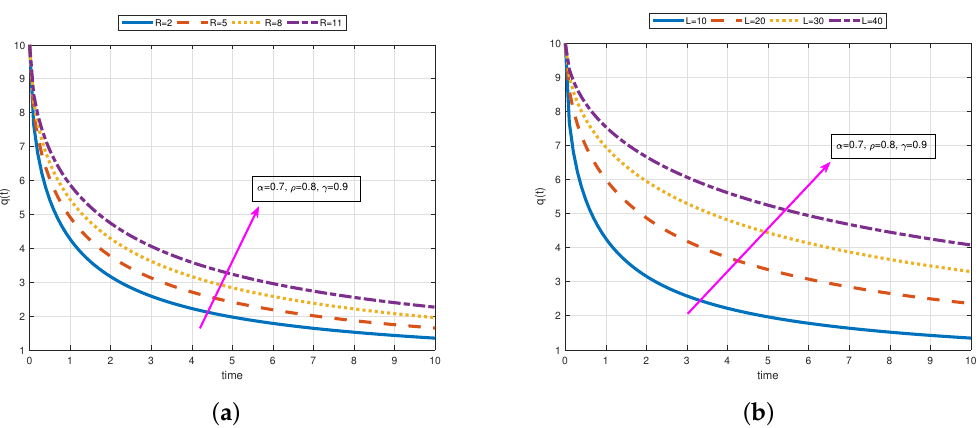
Figure 14. The figure ( a ) is for the function q ( t ) with respect to the constant source for some values of α , ρ , and γ in order to see the impact of R , and the figure ( b ) is plotted to see the effect of L when R = 2 Ω , L = 10 H, C = 0.1 F, e 0 = 5 V, q ( 0 ) = 10, and M D α , ρ , γ q ( 0 ) = 0.